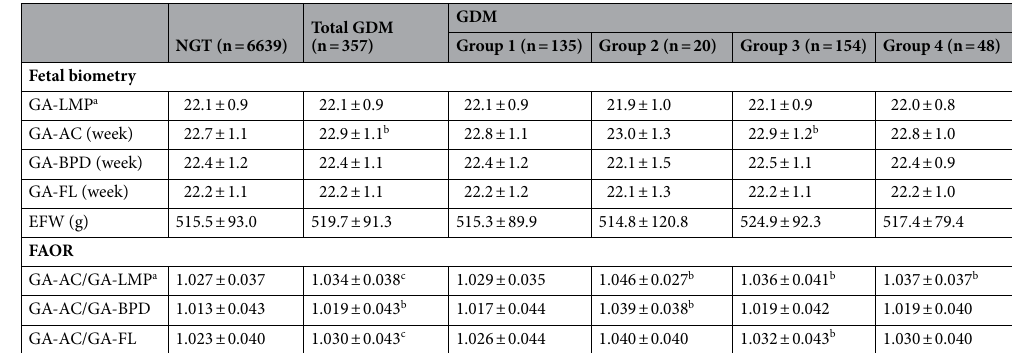
Table 2. Results of fetal biometry and FAORs measured at 20–24 GW in the subjects subsequently diagnosed with NGT and GDM. GW gestational weeks, FAOR fetal abdominal overgrowth ratio, NGT normal glucose tolerance, GDM gestational diabetes mellitus, BMI body mass index, GA-LMP gestational age by last menstruation period, GA-AC estimated gestational age by abdominal circumference, GA-BPD estimated gestational age by biparietal diameter, GA-FL estimated gestational age by femur length, EFW estimated fetal weight; GDM group 1 (age < 35 years and BMI < 25 kg/m 2 ); group 2 (age < 35 years and BMI ≥ 25 kg/m 2 ); group 3 (age ≥ 35 years and BMI < 25 kg/m 2 ); group 4 (age ≥ 35 years and BMI ≥ 25 kg/m 2 ). a Gestational age by LMP at 20–24 GW, b p < 0.05, compared with NGT, c p < 0.001, compared with NGT.